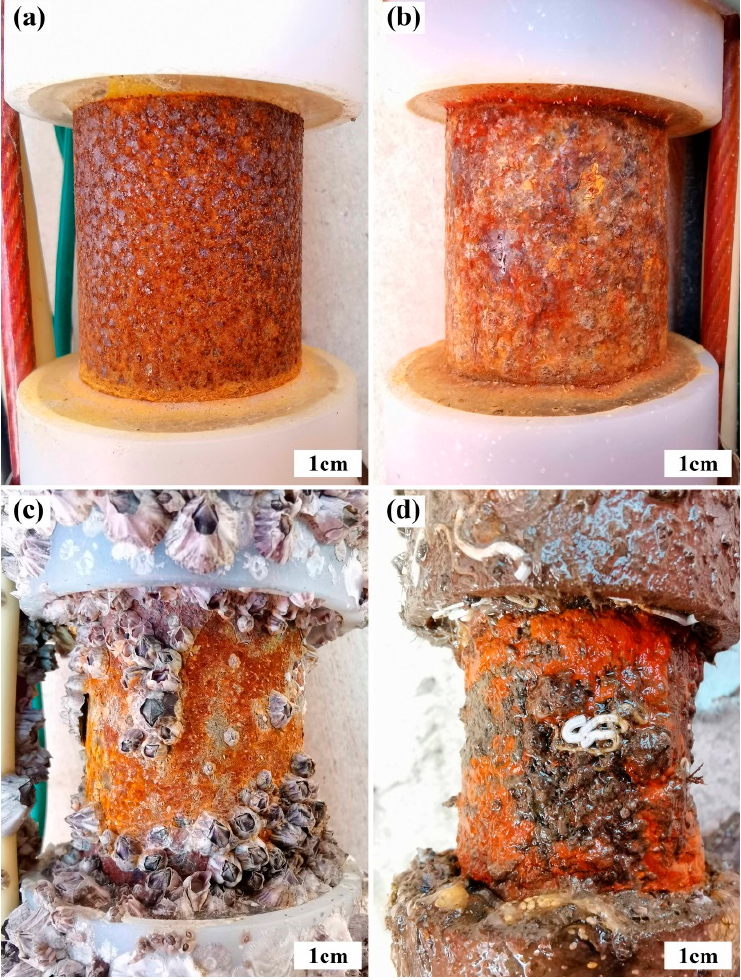
Figure 5. Macro-morphologies of the sensors after being exposed for 3 months in the marine atmospheric zone ( a ), the splash zone ( b ), the tidal zone ( c ) and the immersion zone ( d ).